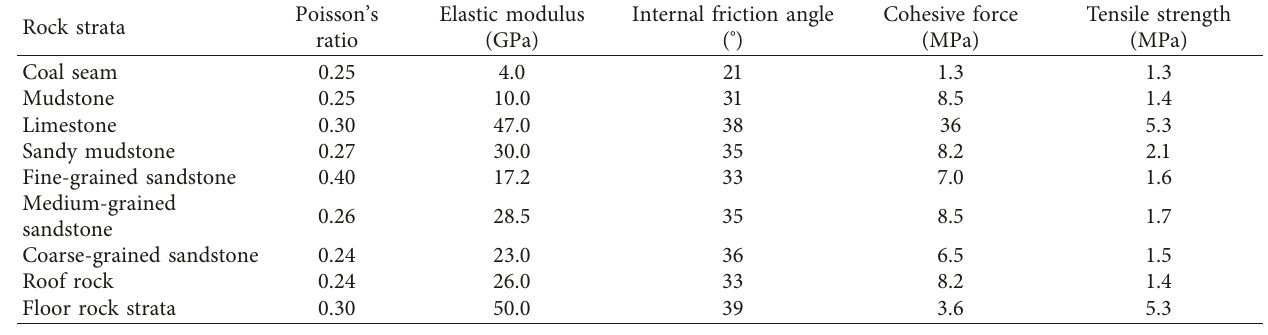
Table 1: Mechanical parameters of rock and floor rock masses.